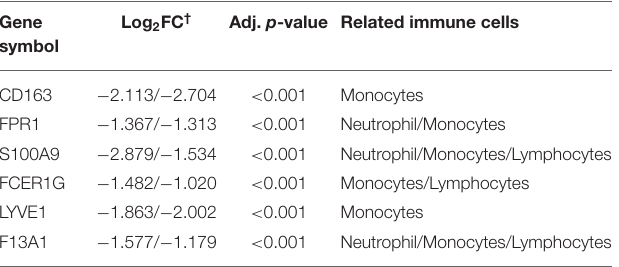
TABLE 1 | Relationships between candidate key genes with immune cells ( † Log 2 FC from